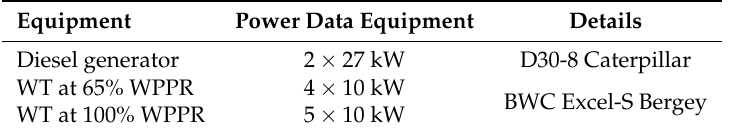
Table 7. Wind–diesel hybrid system with compressed air energy storage